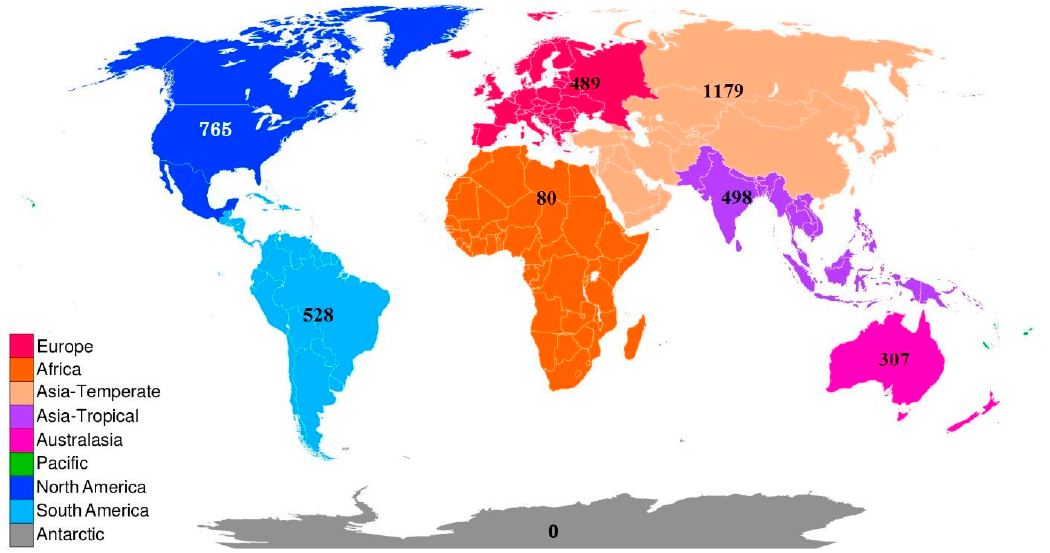
Figure 1. Biodiversity Information Standards (TDWG) Level 1 World Geographical Scheme [37] used in the Plecoptera Species File [9]. Numbers indicate known species richness through 2018.